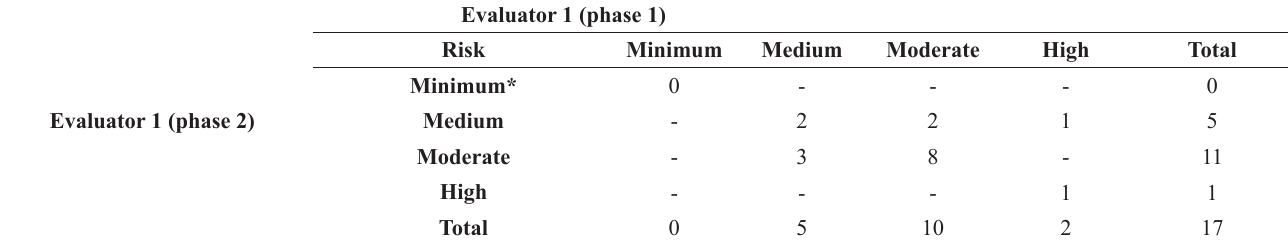
Table 4 - 4x4 table (Intra-rater agreement)